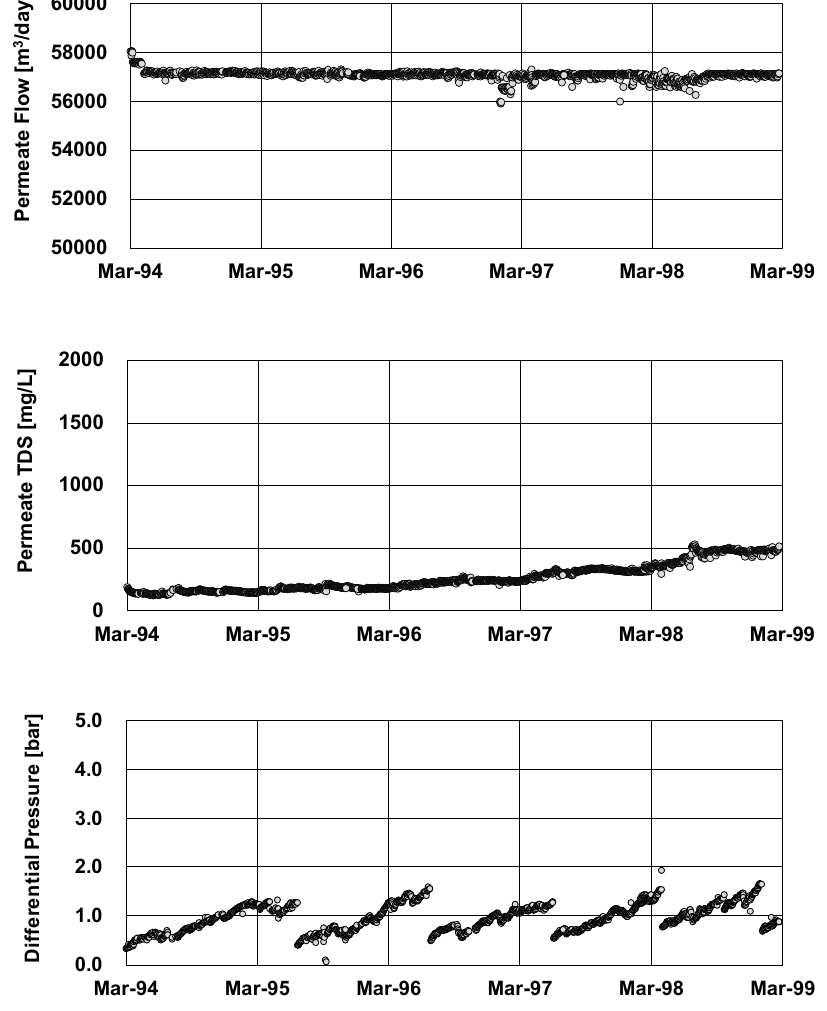
Figure 16. Performance of one of the RO Train in Jeddah 1 phase II plant. Data from [94].